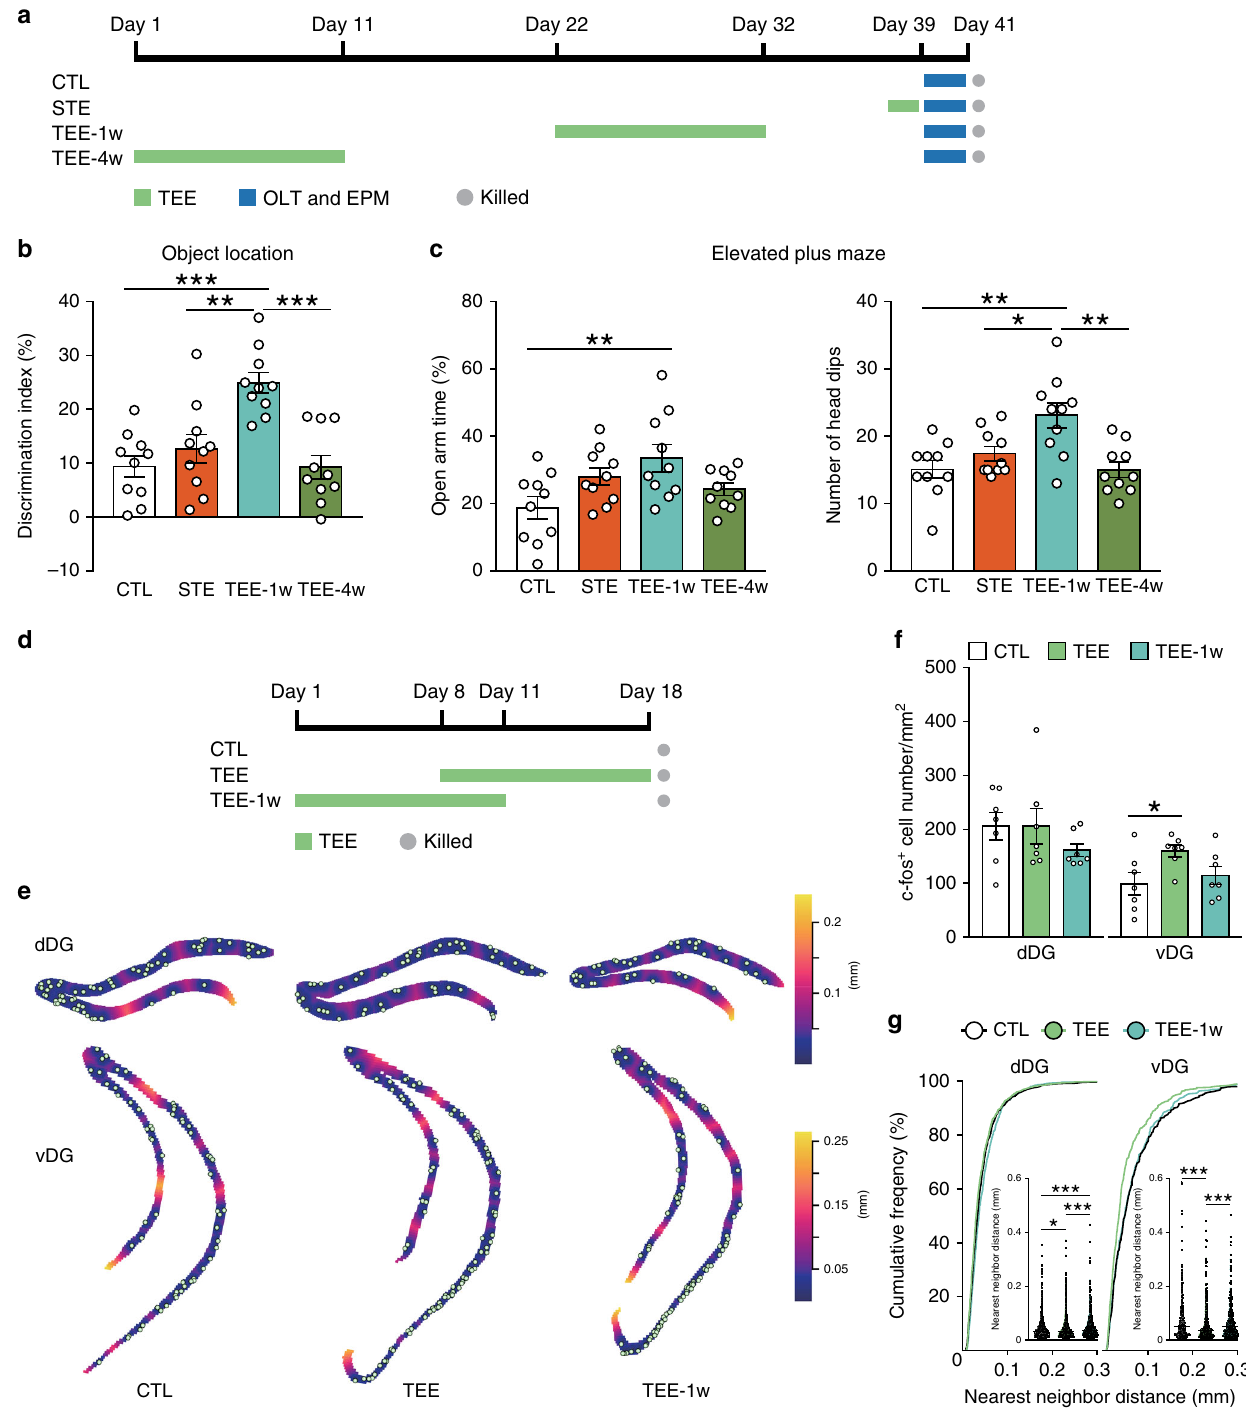
Fig. 3 Temporal effects of tactile enrichment on behavior and DG neuron activation. a Experimental design for the effects of tactile enrichment on memory and anxiety. STE, short-term tactile enrichment; OLT, object location task; EPM, elevated plus maze. n = 10 mice per group. b At 1 week but not 4 weeks after tactile enrichment, improvements in spatial memory performance were still detectable. c At 1 week after tactile enrichment, anxiety level was reduced as shown by increased percentage of time in open arms and number of head dips in the elevated plus maze. d Experimental design for the temporal effects of tactile enrichment on DG neuron activation. n = 7 mice per group. e Representative plots of c-fos + neurons superimposed on empty space distance maps of dDG and vDG. f The density of c-fos + neurons in dDG was similar among groups, whereas the density of activated vDG neurons was increased in the TEE group compared to controls. g Activated neurons in dDG and vDG were more clustered after tactile enrichment ended, but became dispersed again 1 week later. * P < 0.05, ** P < 0.01, *** P < 0.001. Data in bar charts are presented as mean ± SEM. Detailed statistics are provided in Supplementary Table 2. Source data are provided as a Source Data fi